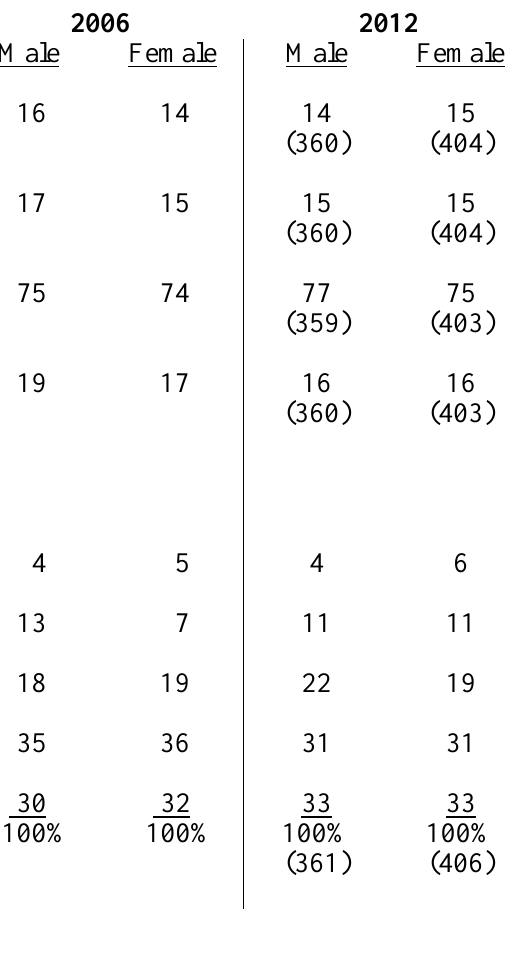
Table 11. Organizational Commitment (percent